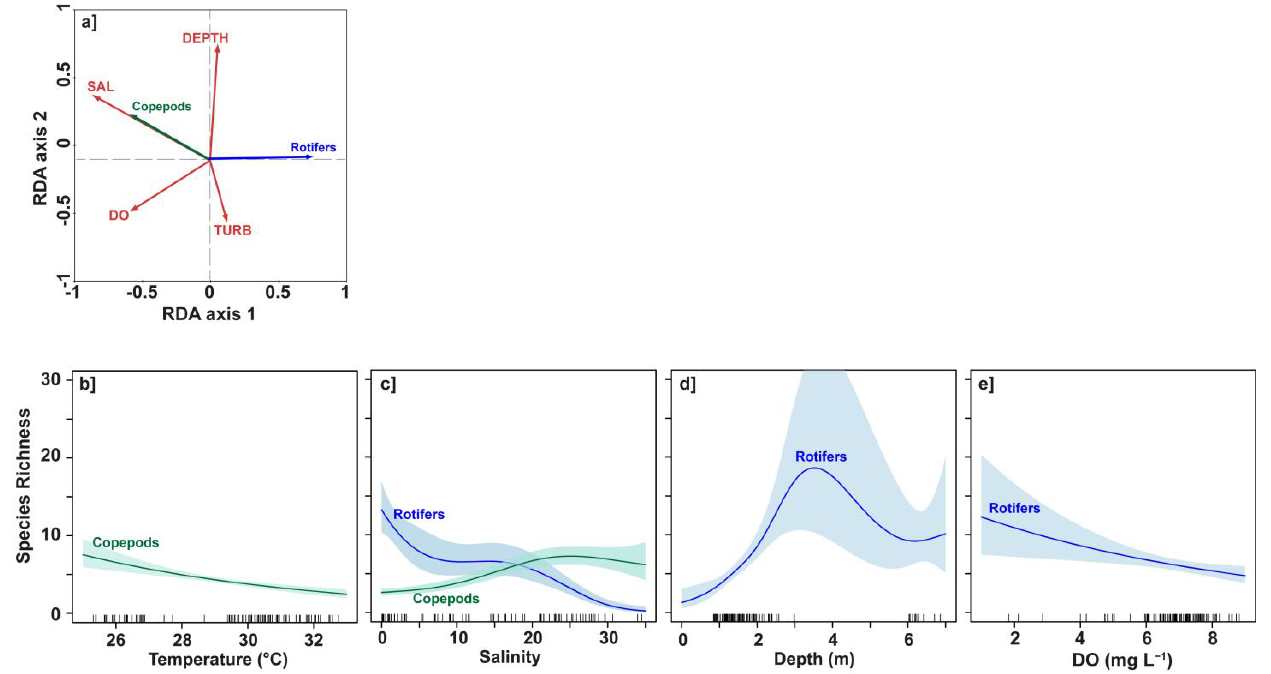
Figure 5. Redundancy analyses (RDA) and generalized additive models (GAMs) relating diversity of copepods and rotifers to environmental variables. ( a ) RDA diagram of species richness and environmental parameters. ( b – e ) GAMs of species richness versus temperature (TEMP), salinity (SAL), depth (DEPTH) and dissolved oxygen (DO). Only significant ( p < 0.05) relationships are shown for copepods and rotifers. Shaded areas indicate the 95% confidence intervals.